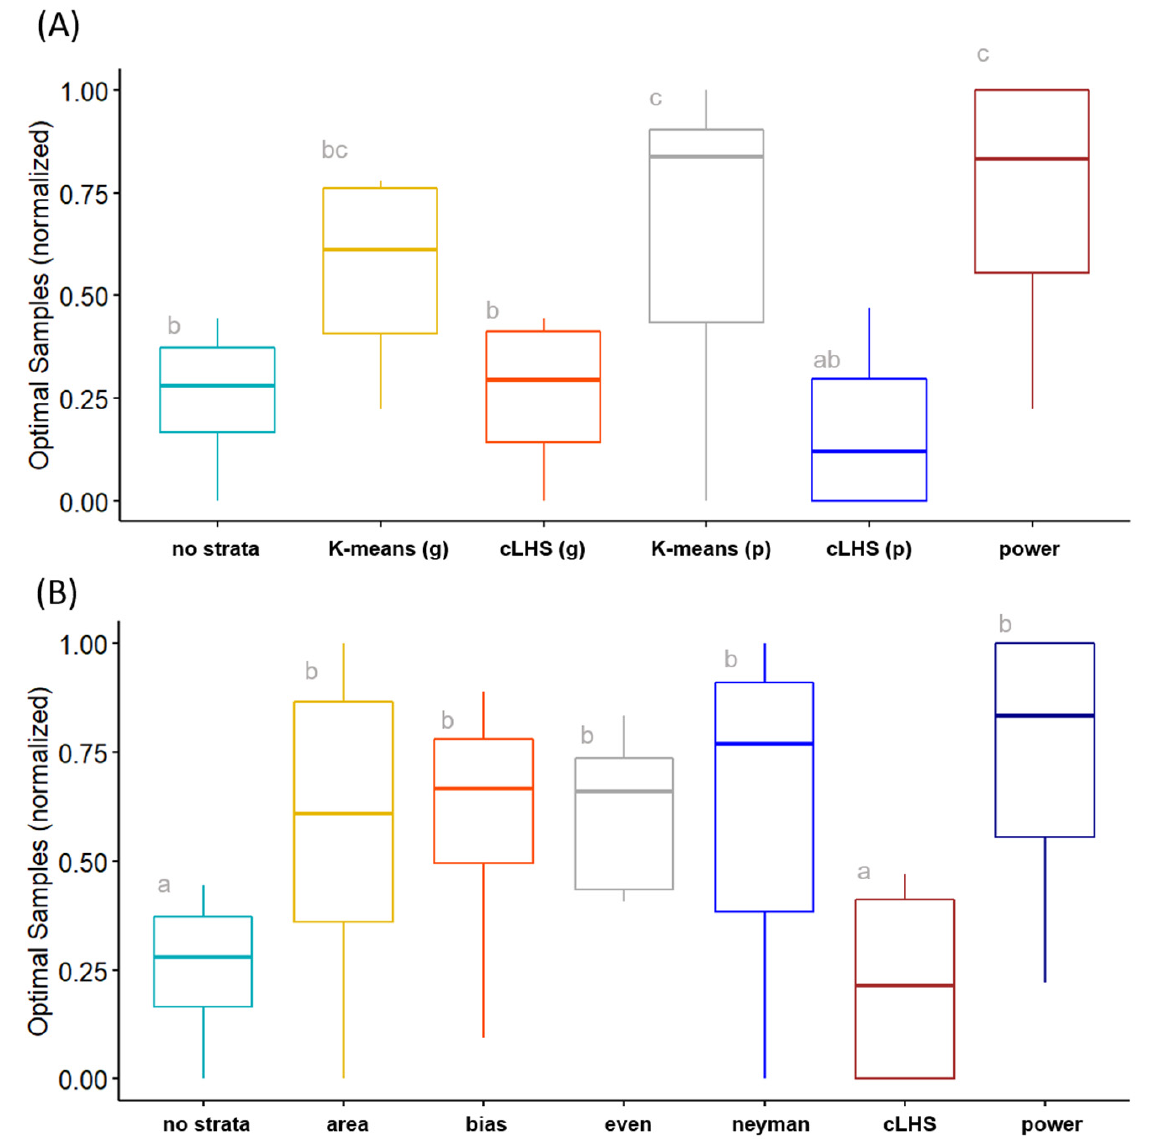
Figure 6. Summaries across all study sites (5 strata only). ( A ) Submodels grouped across study sites and types of inputs to K-means and cLHS. ( B ) Models grouped by in-strata sampling. In both ( A , B ), sampling intensities have been normalized at each site from 0 to 1, with zero being the submodel with the lowest sampling intensity and one as the submodel with the highest sampling intensity. Labels on individual boxes reflect results from ANOVA, reflecting significant differences between groups a, b, and c.